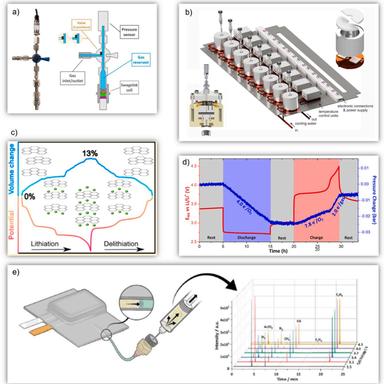
.1. Schematic representations of experimental setups and data of PMS and GC–MS systems. (a) PMS for Li-O2 battery testing with relatively large gas reservoir; (b) multichannel PMS system for degradation studies of LIBs; (c) PMS data of volume changes during lithiation of graphite anode; (d) PMS data measuring the stoichiometry of the discharge and charge processes of a Li-O2 cell (e) Potential dependent in situ GC–MS schematic and data.